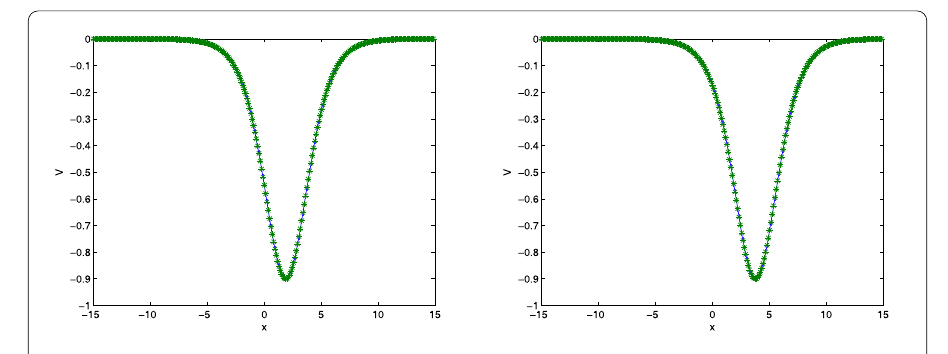
Figure 3 The wave forms of the numerical solutions for t = 6